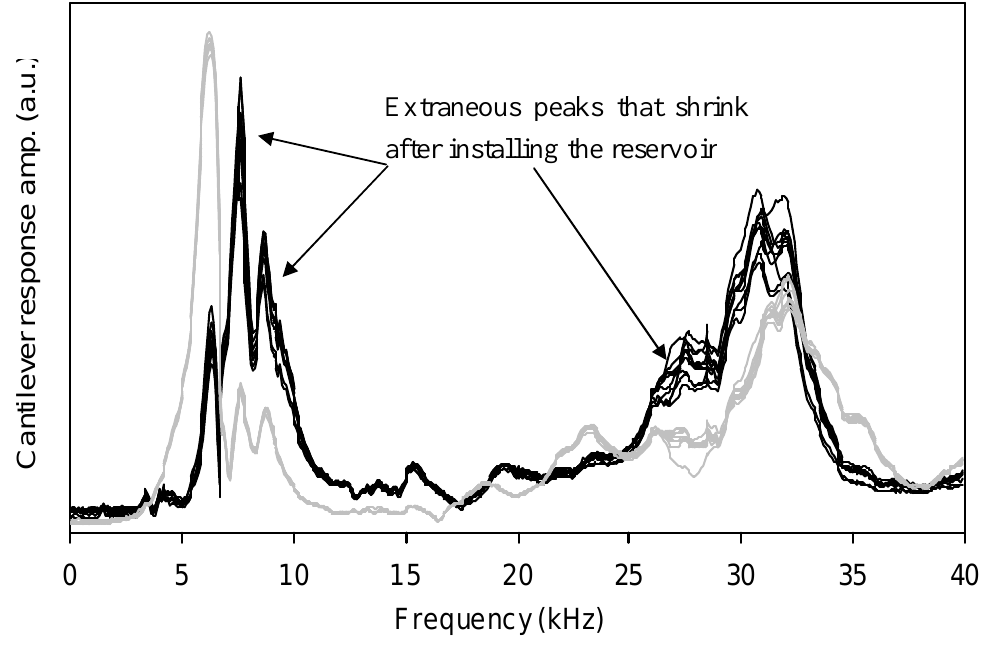
Figure 6. Frequency responses of cantilever 3 in 50% glycerin-water solution before (black line) and after (gray line) installing the reservoir. The cantilever is glued to the fluid